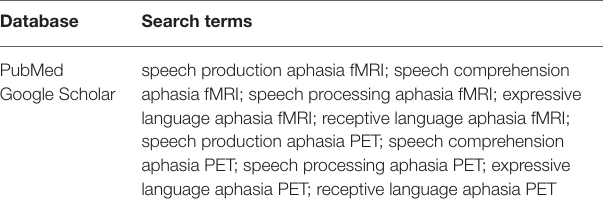
TABLE 1 | Search terms for each